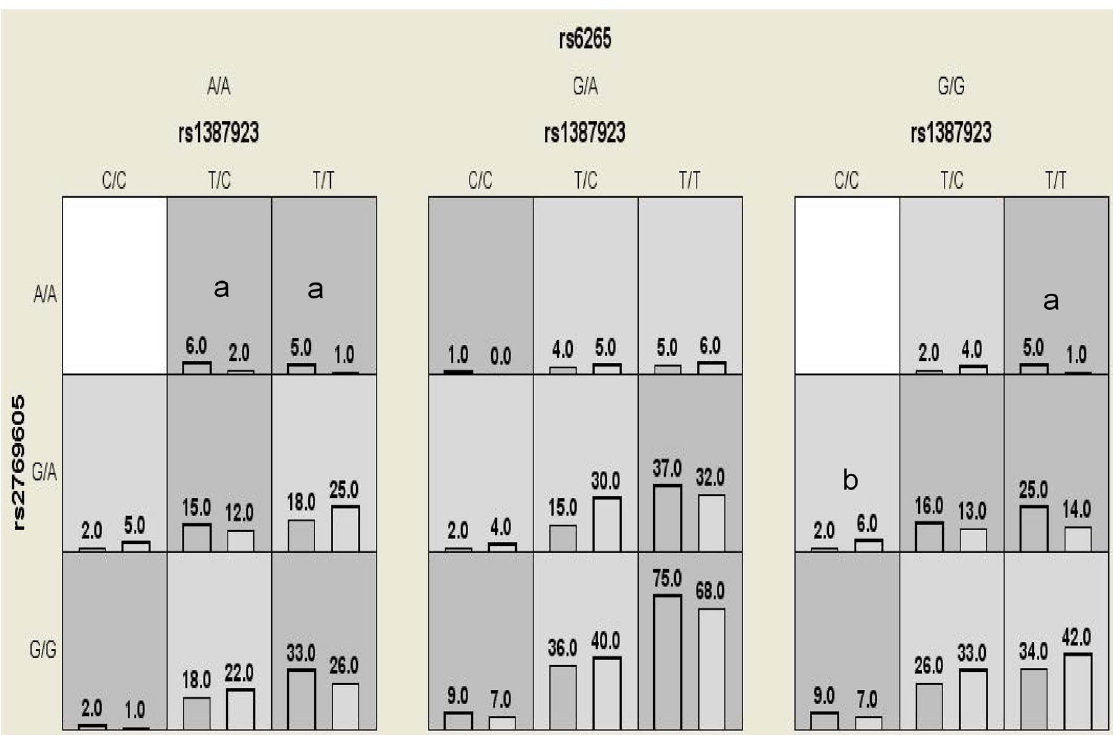
Figure 1. Distribution of high-risk and low-risk genotypes in the best three-locus model. Dark gray and light gray boxes presented the high- and low-risk factor combinations, respectively. Left bars within each box represented case while the right bars represented control. The heights of the bars are proportional to the sum of samples in each group. Note that the patterns of high-risk and low-risk cells differ across each of the different multilocus dimensions. This is evidence of epistasis, or gene-gene interaction. ‘‘a’’ and ‘‘b’’ represented high-risk and low-risk genotype combinations respectively which were also validated by traditional statistical analysis.